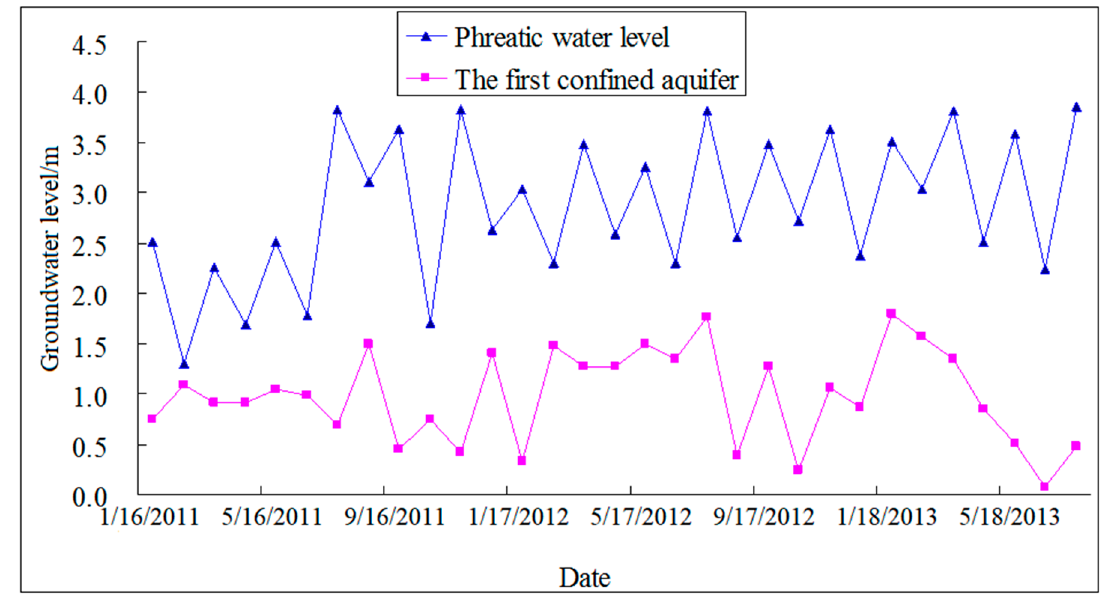
Figure 4. Dynamic variation of groundwater level.